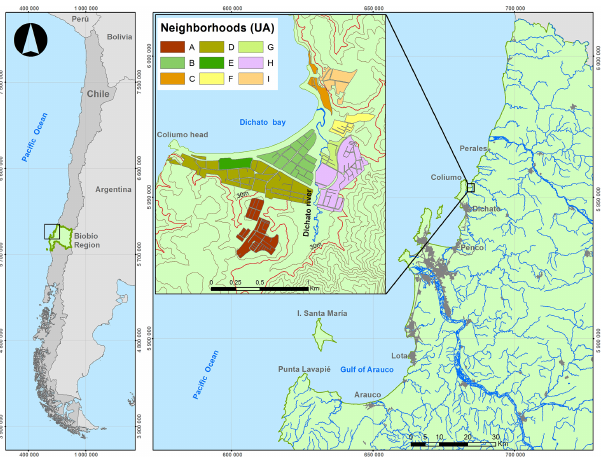
Figure 1. Geographical context of the study area. Dichato is located on Coliumo Bay (36 ◦ S). The letters (A–I) identify different neigh- borhoods analyzed in the post-disaster period.